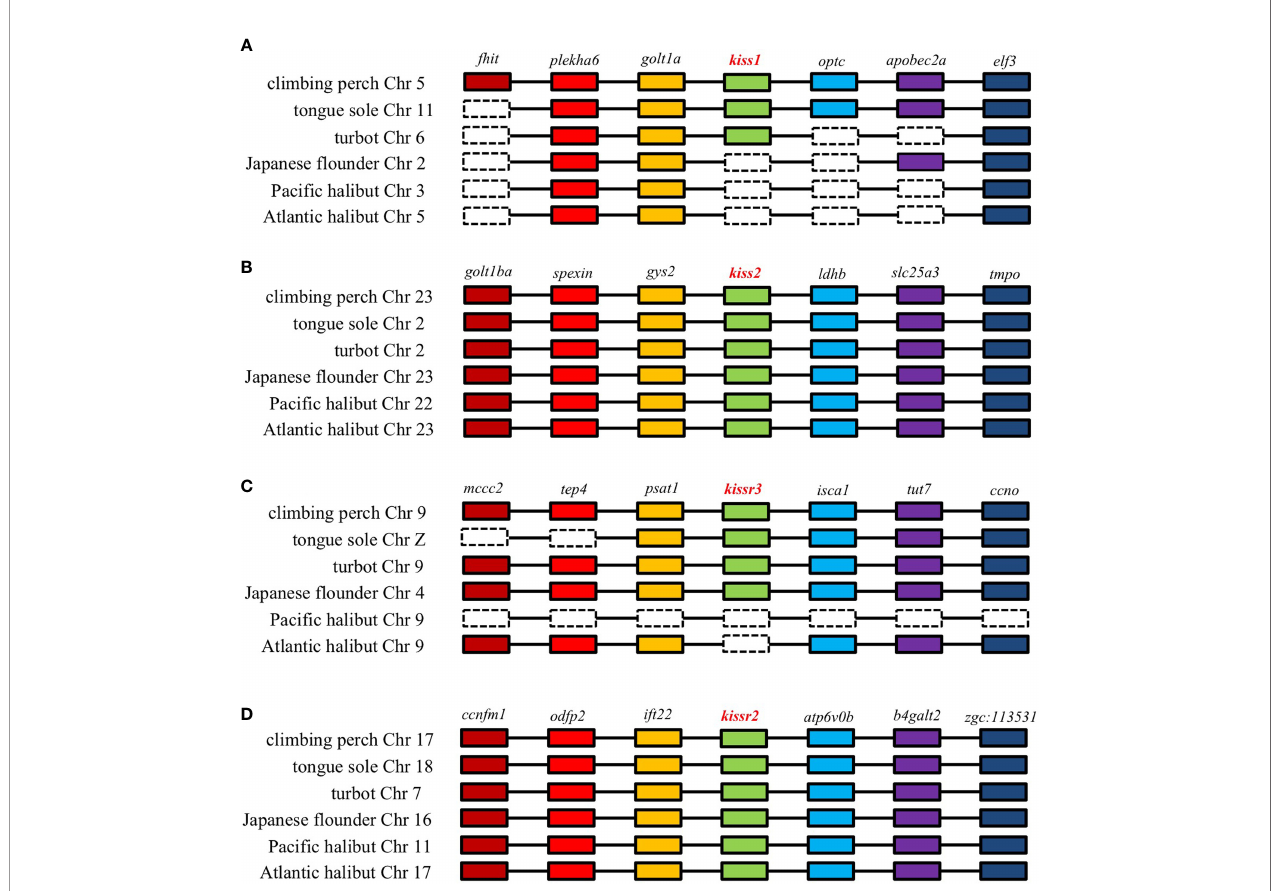
FIGURE 2 | Genomic synteny analysis of kisspeptin (A, B) and its receptor (C, D) genes in different teleost